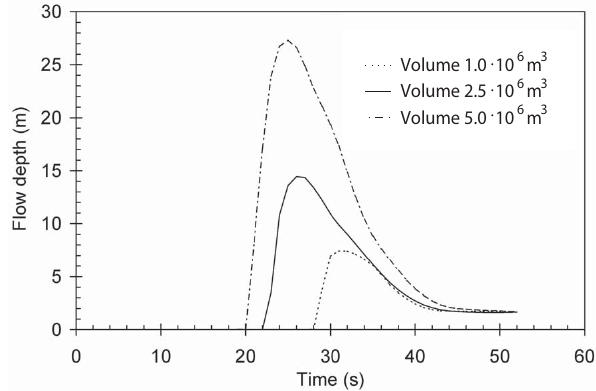
Fig. 11. Longitudinal profile of the expected surface geometry of the Triftgletscher tongue in 2008, with maximal flow velocities for the several ice-avalanche volume scenarios calculated with AVAL- 1D. This points out the limits of the chosen calving criterion.